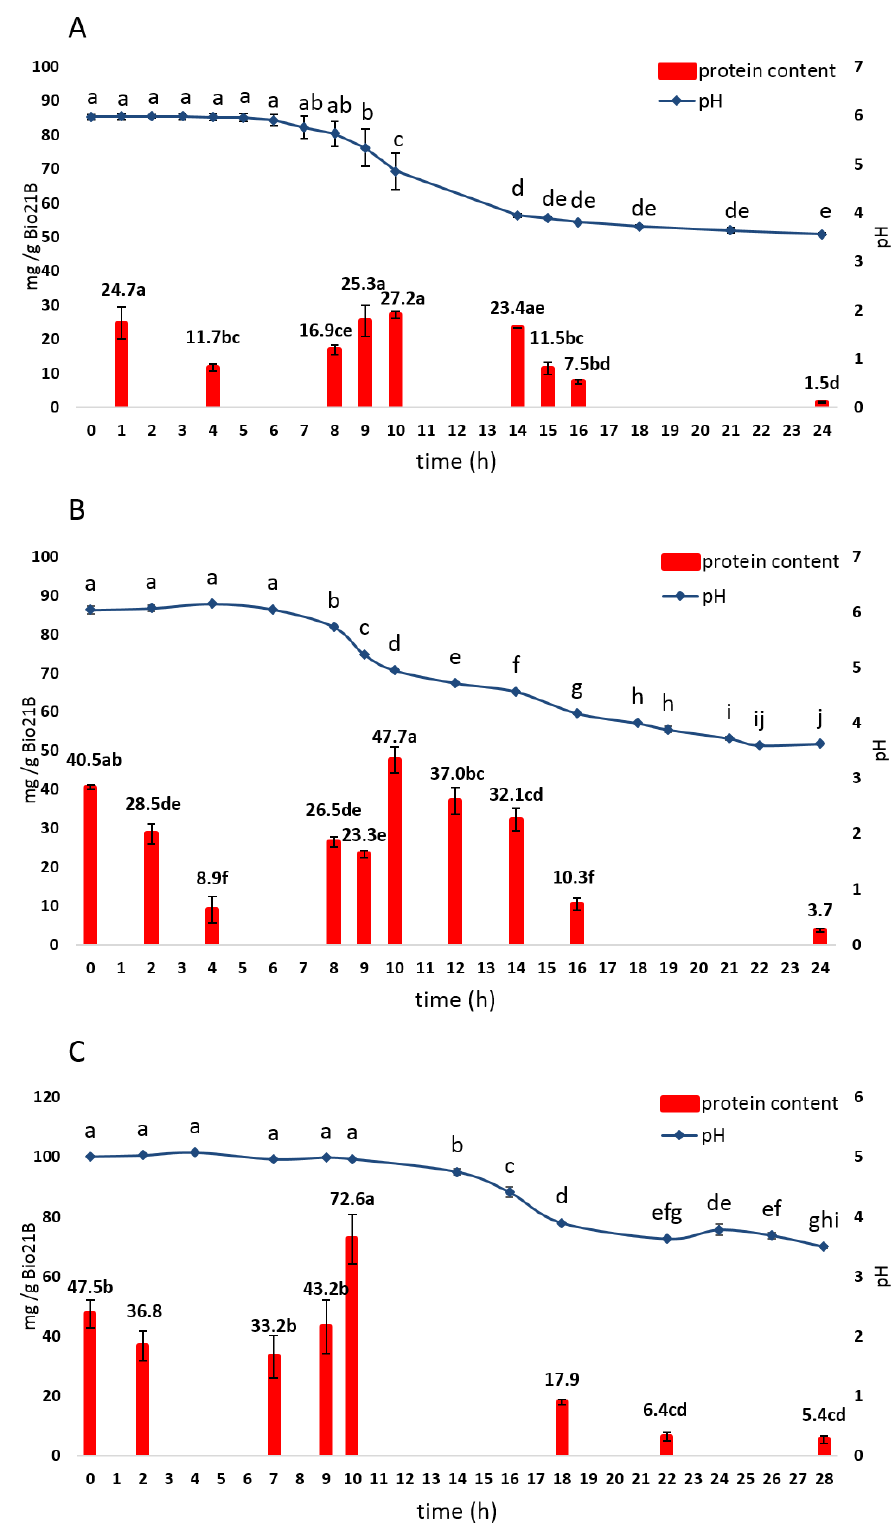
Figure 3. pH values and total protein content (mg/g) in liquid sourdough Bio21B-1 ( A ), Bio21B-2 ( B ), and Bio21B-3 ( C ) prepared as reported in Section 2.3 and Table 1, registered during fermentation. The values represent means of triplicates ± standard deviation. Different letters mean significant statistical differences ( p < 0.05) among fermentation times within the same sample as determined by one-way ANOVA followed by Tukey’s HSD test.